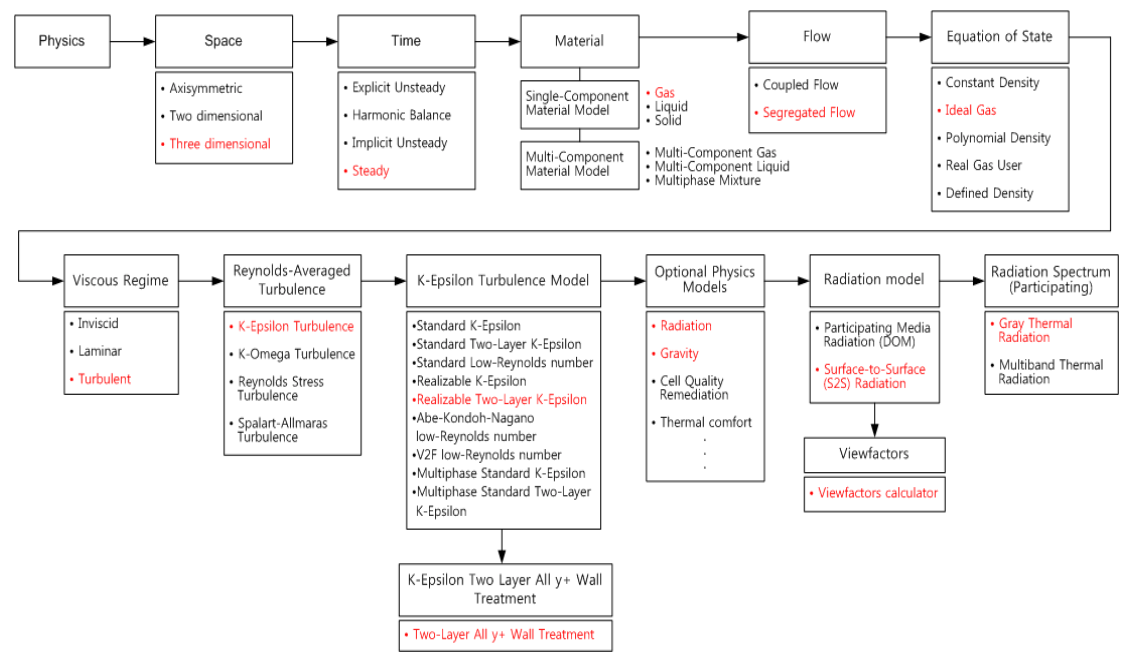
Figure 4. The numerical models of the computational fluid dynamics (CFD) simulation. Appl. Sci. 2017 , 7 , 1075